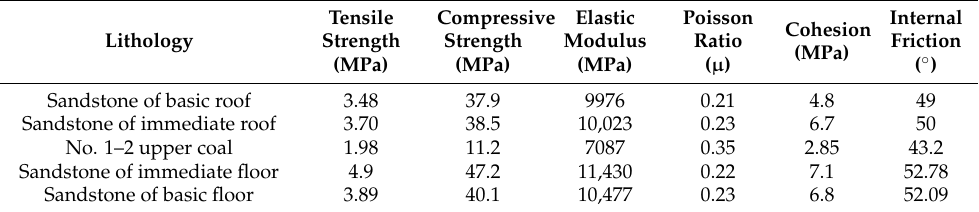
Figure 4. Rock mechanics parameter test: ( a ) rock samples; ( b ) RMT-150B electro-hydraulic servo testing machine. Table 1. Rock mechanical parameters.